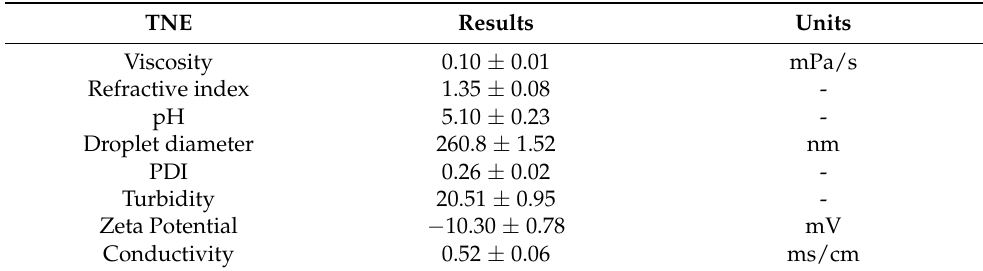
Table 2. Physicochemical characterisation of TNE. Data presented as mean ( n = 3) ± standard deviation